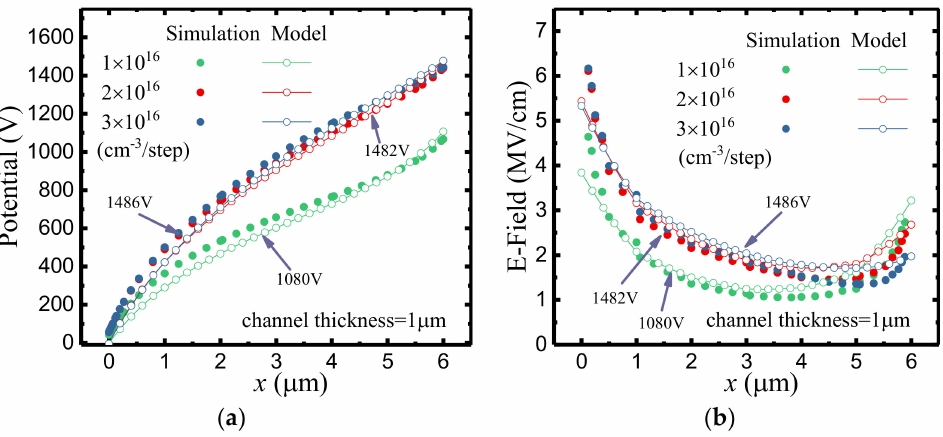
Figure 7. ( a ) The potential distributions and ( b ) the E–field distributions of SDC–HEMTs with different doping gradients.